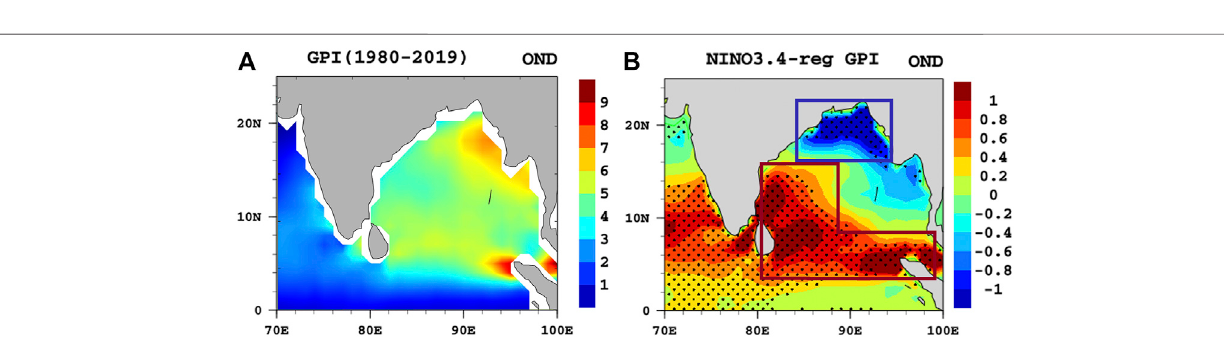
Frontiers in Earth Science |